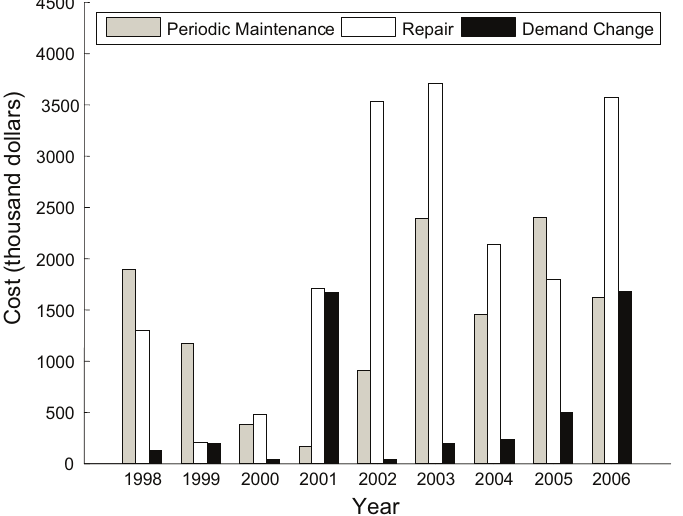
figure 3. Cost histogram of the east site